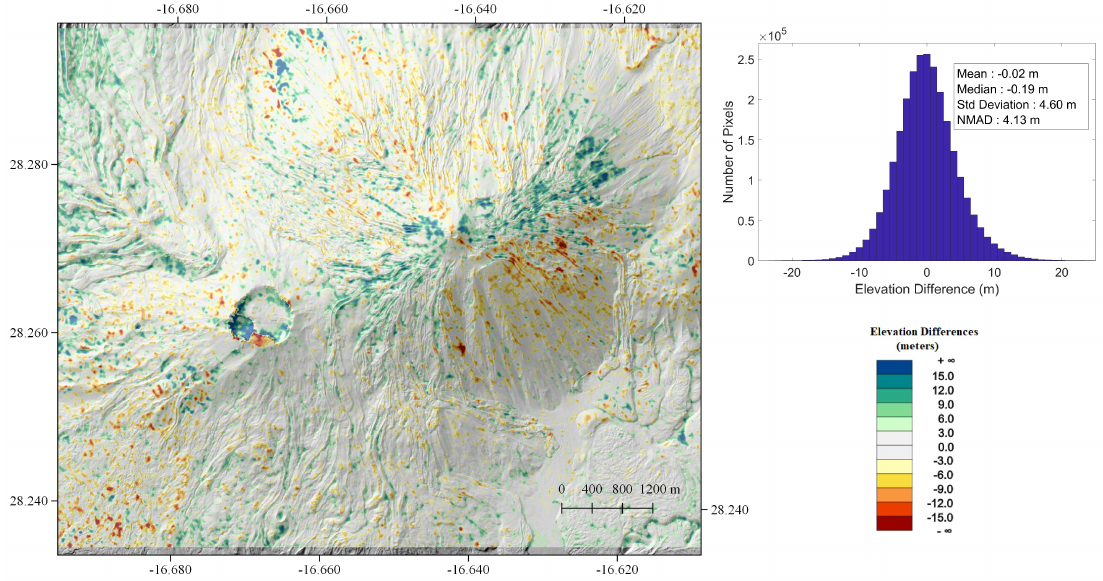
Figure 8. Elevation Differences over Mount Teide computed from the difference of the LiDAR based DTM and the PlanetScope